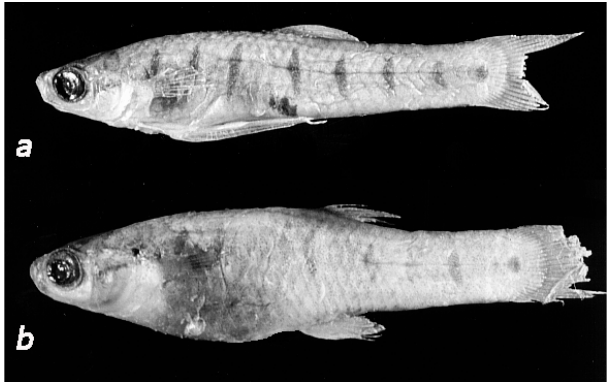
Fig. 5. Cnesterodon iguape : (a) holotype, male, MZUSP 79672, Apiaí, São Paulo, Brazil, 22.3 mm SL; (b) paratype, female, MZUSP 54978, 24.8 mm SL, collected with the holotype. [adult males], 20.0-30.5 mm [adult females], respectively) and by its color pattern (one to four clearly rounded dark spots or wide and short bars along flanks vs . six to nine dark brown circular to irregular blotches or vertical wide bars along body sides,